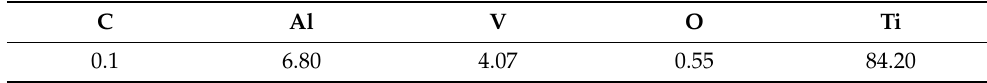
Table 2. Chemical composition (wt. %) of work material (Ti-6Al-4V).